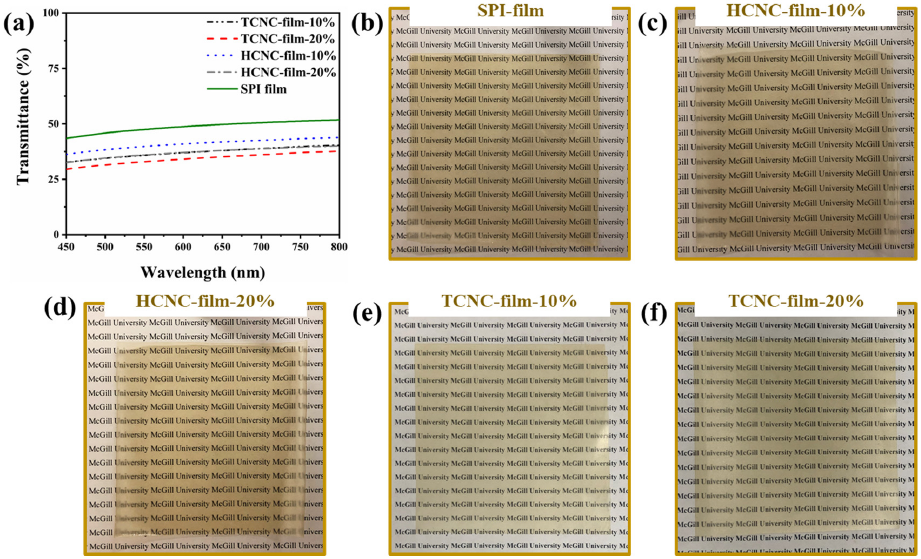
Figure 5. Optical transmittance ( a ) and photos ( b – f ) of SPI and SPI / CNC films.